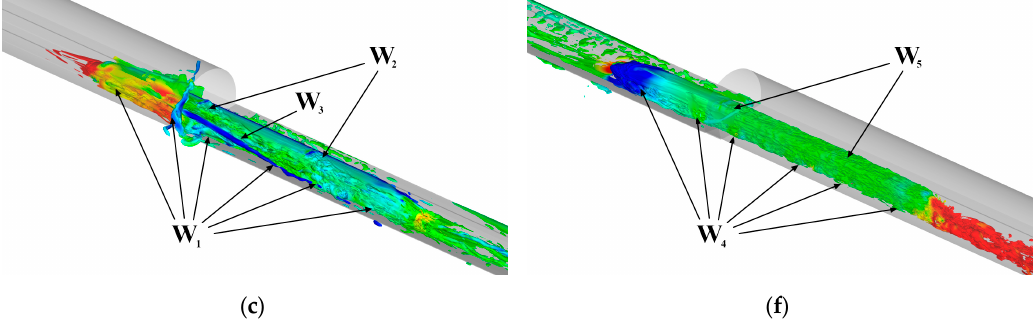
Figure 16. Isosurface of Q = 100 coloured with (cid:1829) (cid:3043) . ( a ) Case 1 at t 2 = 1.285 s; ( b ) Case 2 at t 2 = 1.285 s; ( c ) Case 3 at t 2 = 1.285 s; ( d ) Case 1 at t 6 = 4.369 s; ( e ) Case 2 at t 6 = 4.369 s; and ( f ) Case 3 at t 6 = 4.369 s.